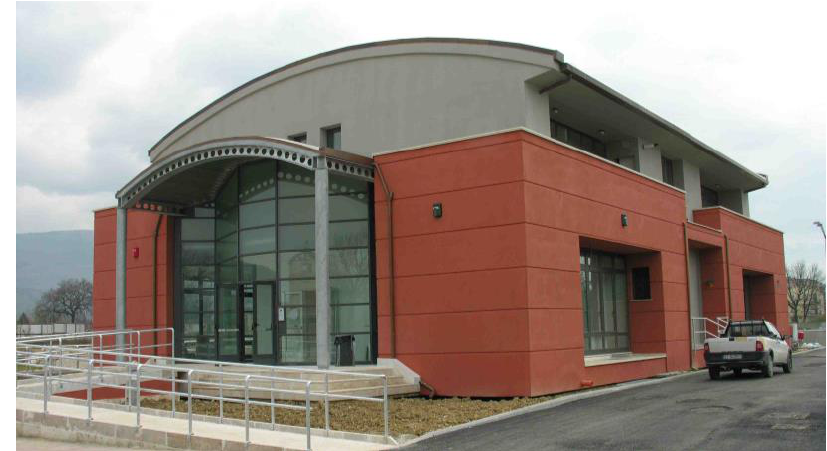
Figure 1. View of the Forest Ranger building (photo P. Clemente).